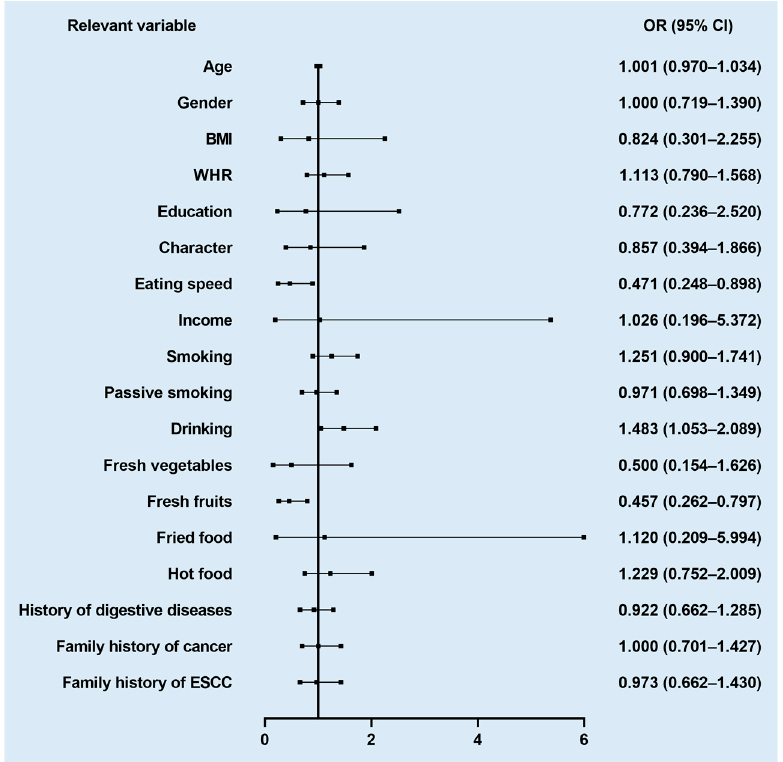
Figure 2. Forest plot of association between relevant variables and EPL risk. As shown in Table 2, the levels of plasma niacin ( p for trend = 0.632) and nicotinamide ( p for trend = 0.804), and the concentration of NAMPT ( p for trend = 0.641) showed no significant association with EPL risk after model adjustment. However, compared with the first quartile, the other three quartiles of NAPRT were positively associated with EPL risk ( p = 0.014, 0.001, and 0.016, respectively). In addition, we found a positive linear rela- tionship between the concentration of PARP-1 and EPL risk ( p for trend = 0.021). Further analysis after gender differentiation revealed that this association could only be found in male subjects (Table 3). Table 2. ORs (95% CIs) of relevant variables for NAD with EPL.